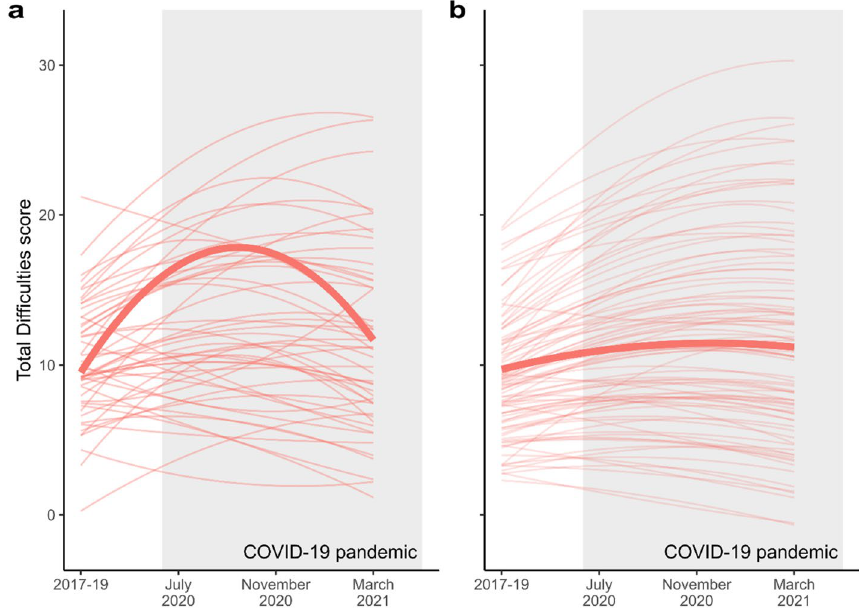
Figure 4. Latent growth curve models of SDQ Total Difficulties scores for those adolescents without access to a computer ( a ) and without access to a good internet connection ( b ). Predicted individual trajectories are also shown and demonstrate the size of the group in each